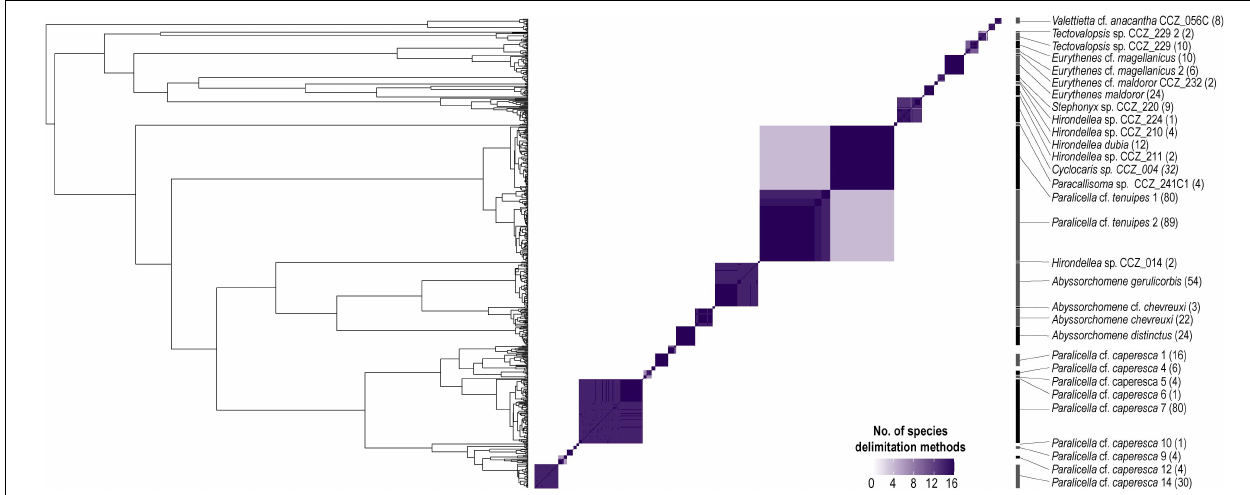
FIGURE 5 | Bayesian phylogenetic tree from COI-only data (CCZ dataset; i.e., 585 sequences) indicating species delimitation for the 30 genetic species found to occur in the western CCZ. Tip labels representing specimens distributed in the western CCZ are highlighted. The heatmap indicates the number of species delimitation methods that recovered each different cluster, with species boundaries considered for downstream analyses indicated on the right. Number in brackets indicates number of